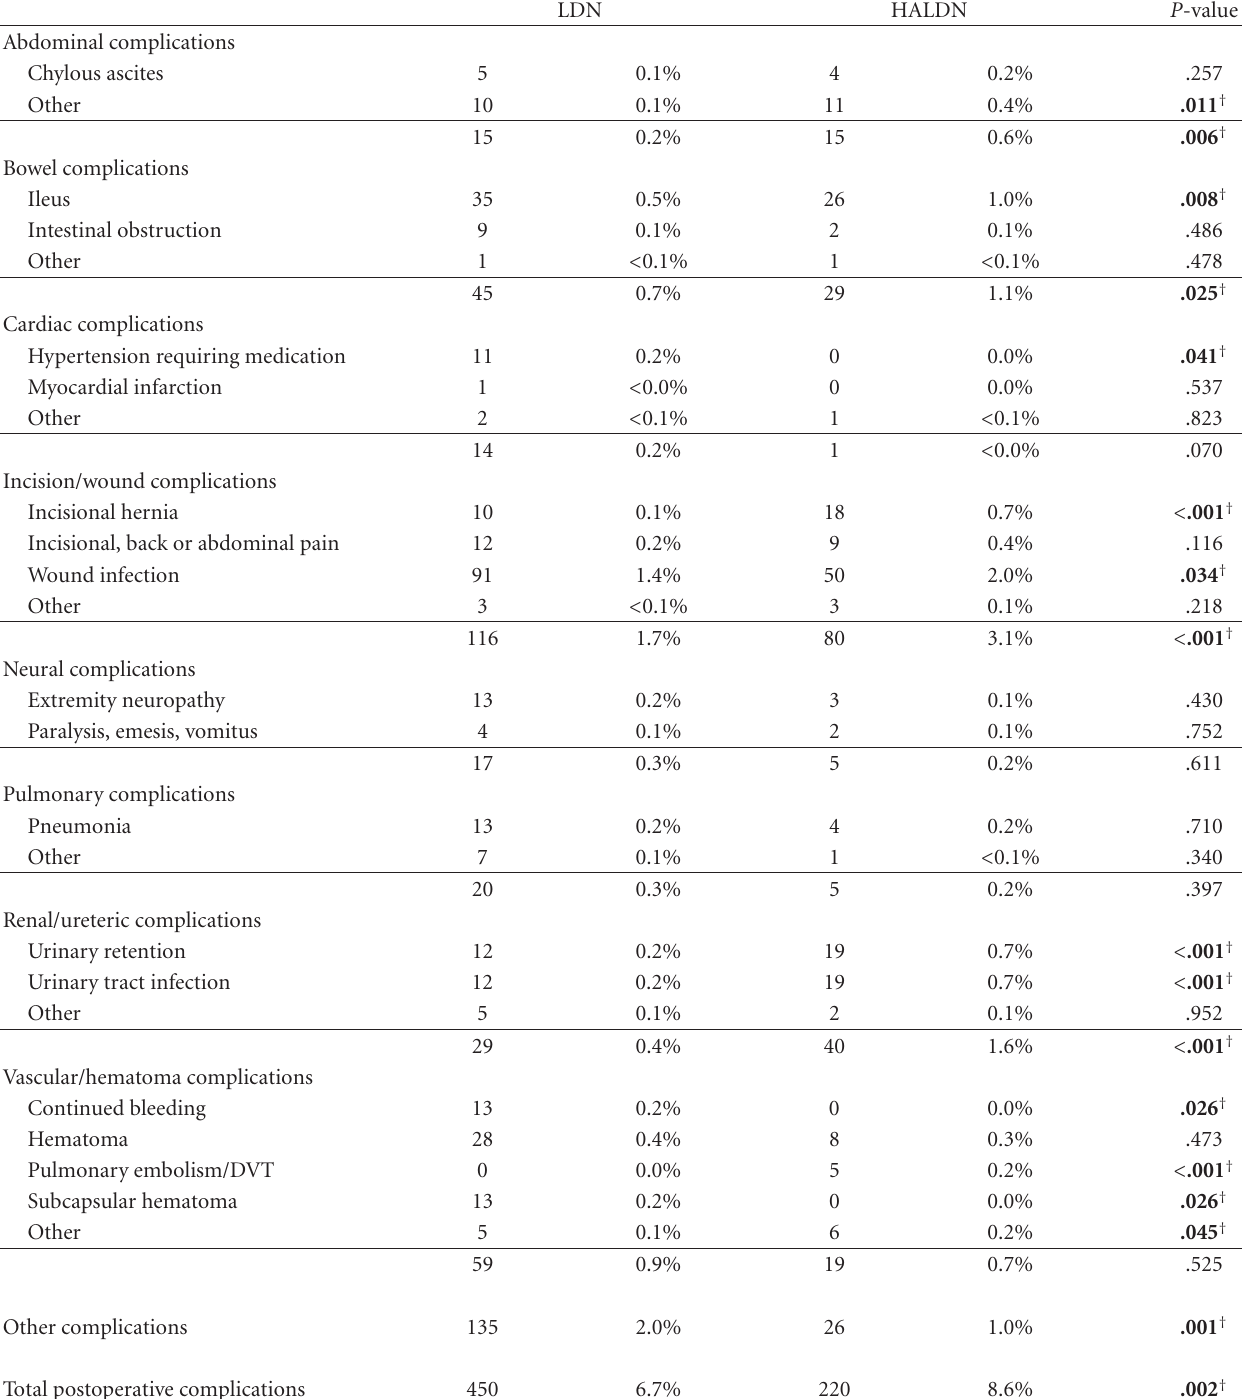
Table 3: Postoperative complications of LDN and